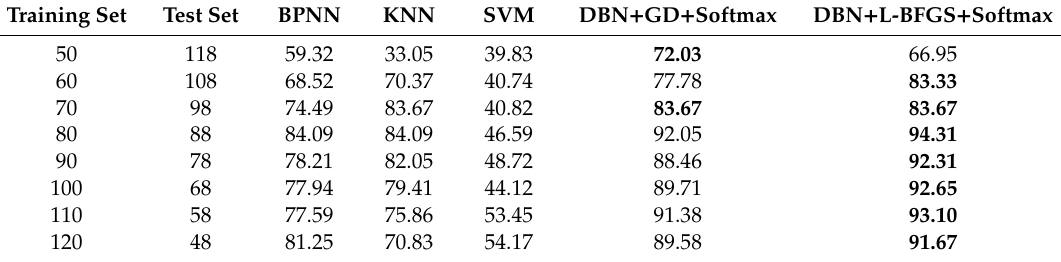
Table 3. Classification accuracies of di ff erent training and test sets